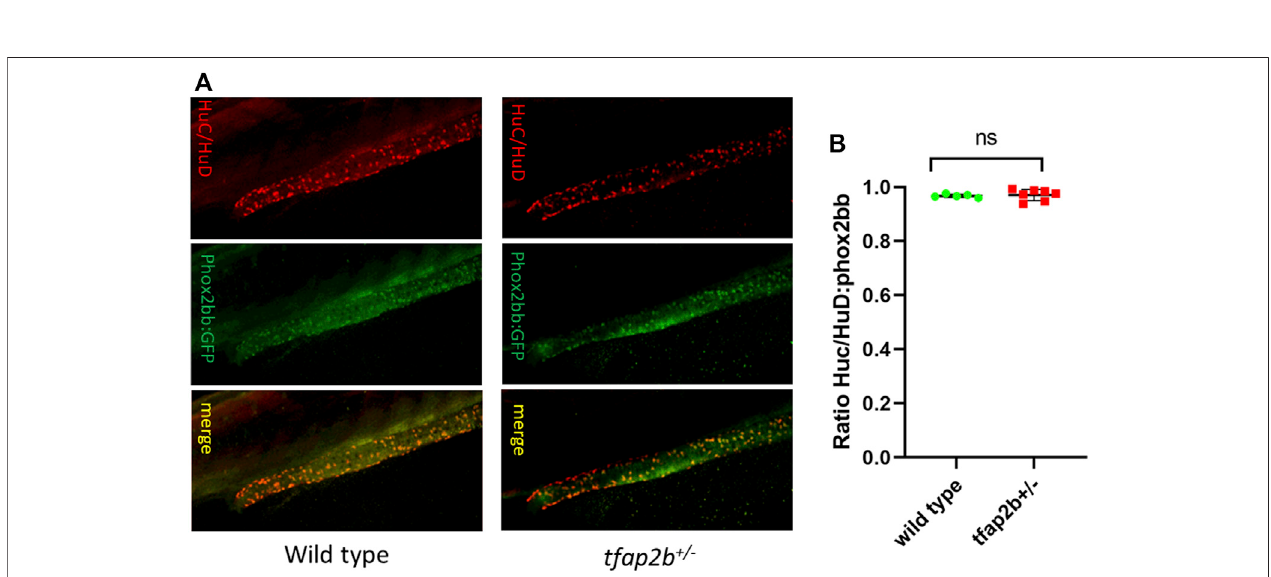
FIGURE5| Differentiatedentericneuronsin tfap2b +/ − fi sh. (A) ConfocalmicroscopeimagesofHuC/HuDandphox2bb:GFPpositivecellsinwildtypeand tfap2b +/ − F2 fi sh. (B) No signi fi cant difference in the ratio of HuC/HuD and phox2bb:GFP positive cells in wild type and tfap2b +/ − F2 fi sh was found ( p > 0.05, unpaired t -test).